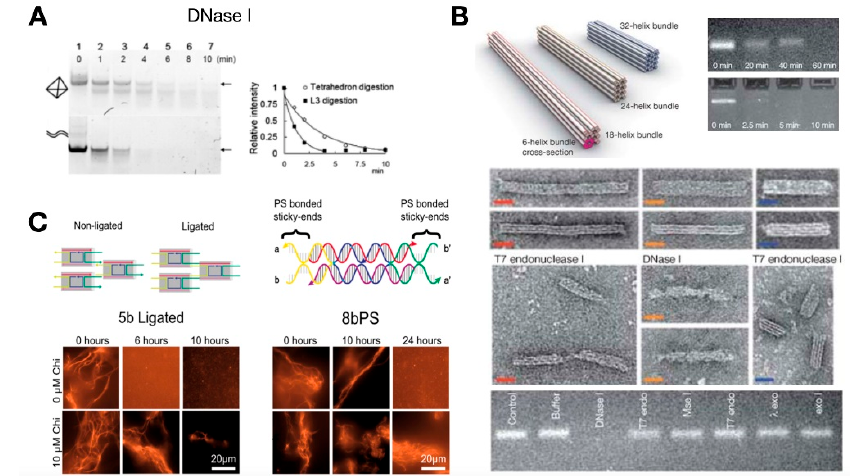
Figure 9. Characterization of DNA structures in cell-like media. ( A ) Denaturing polyacrylamide gel electrophoresis (PAGE) of tetrahedron and duplex DNAs with nonspecific degradation by DNase I. Digestion of the unligated tetrahedron is gradual and appears to generate a well-defined product, whereas digestion of linear DNA appears to be rapid and nonspecific. Reproduced with permission from [123]. ( B ) Stability of honeycomb-packed DNA nanostructure: 140 nm (18-helix bundle), 100 nm (24-helix bundle), and 70 nm (32-helix bundle), from left to right, were used for stability screening with TEM and agarose gel electrophoresis. Scale bar = 20 nm. Reproduced with permission from [124]. ( C ) Enhanced stability of DNA nanotubes with χ -site integration and chemical modifications in E. coli TXTL system. Fluorescence microscopy images of five-base DNA nanotubes with ligation of tile sticky ends and eight-base DNA nanotubes with phosphorothioate-bonded tile sticky ends incubated in TXTL with and without χ -site DNA present. Scale bar = 20 µ m. Reproduced with permission from [126].